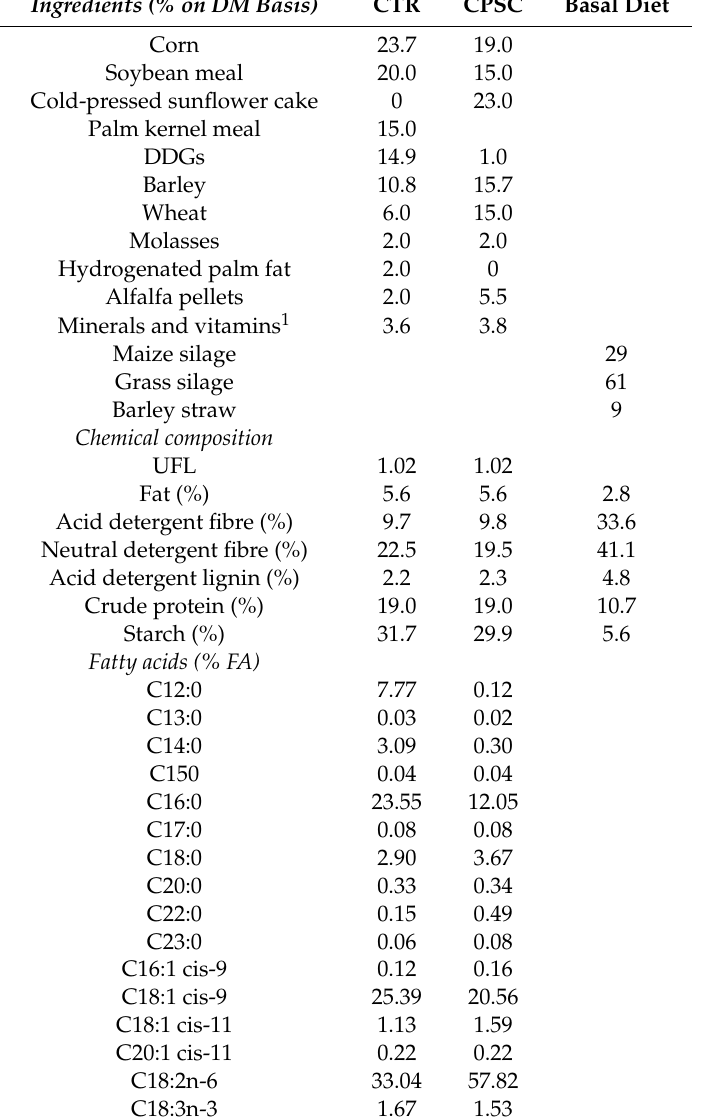
Table 1. Basal diet, ingredients of concentrates and chemical